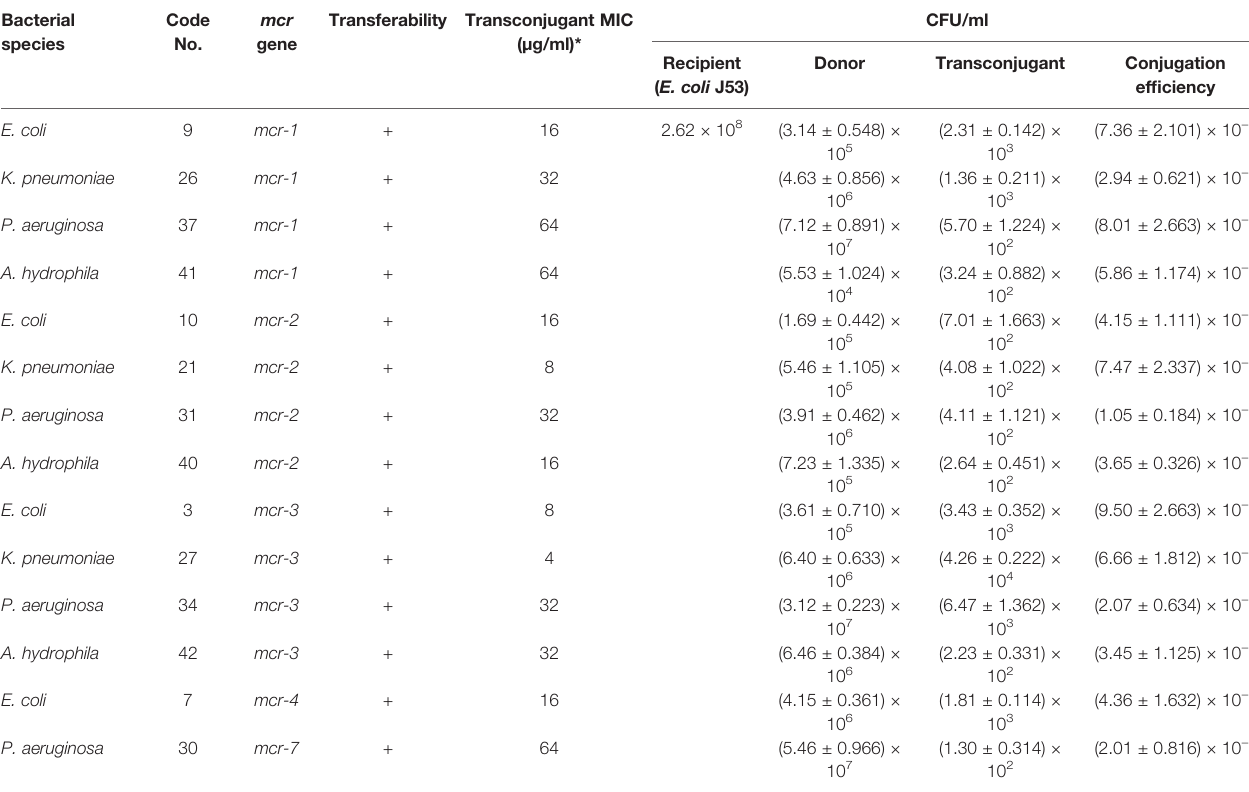
TABLE 3 | Conjugation ef fi ciencies of some mcr-1 -, mcr-2 -, mcr-3 -, mcr-4 -, and mcr-7 -positive isolates and colistin MIC values for transconjugants. Bacterial Code species No.